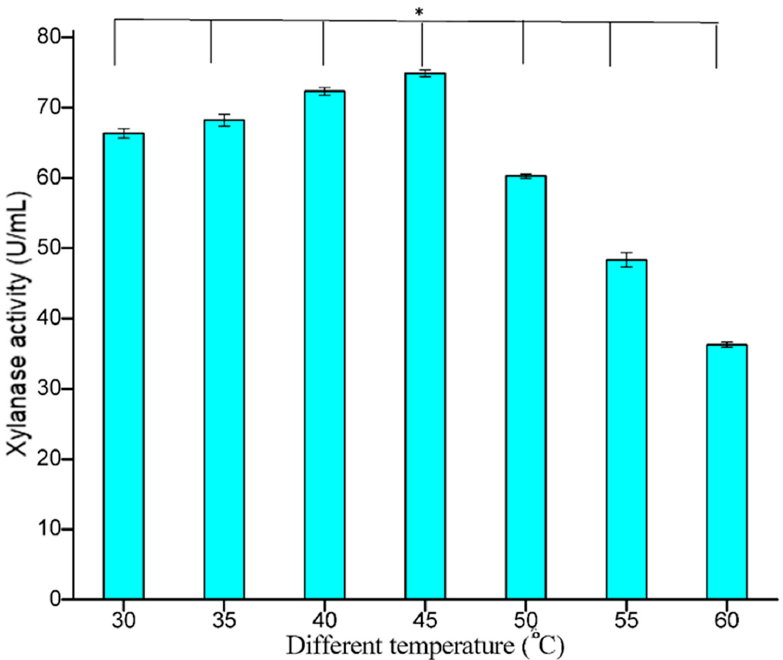
Figure 8. Effect of temperature on the production of xylanase by B. safensis XPS7 (Medium: M5, temp.: 30 to 60 °C; time: 24 h; pH: 9; inoculum: 4%). All the experiments were performed in triplicate. post hoc test, with p < 0.01